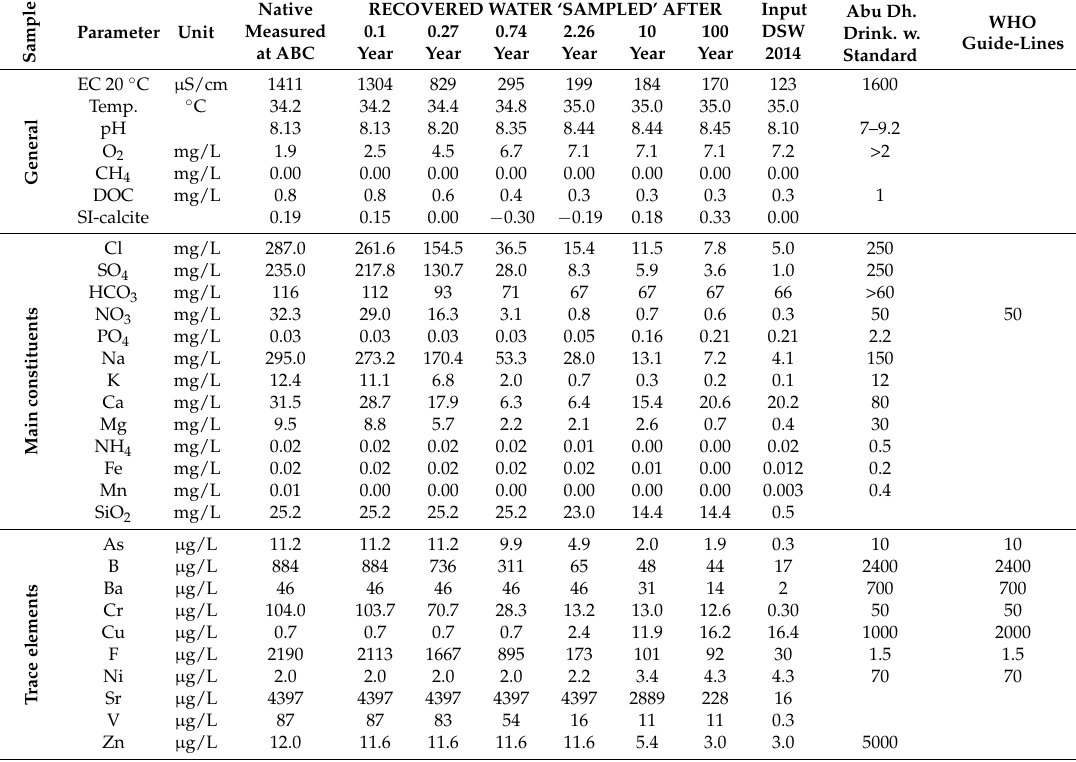
Table 5. Overview of water quality in the SWSR ASR scheme, showing input DSW (Desalinated Seawater), mean native groundwater (when sampled by all wells) and groundwater as if it were periodically sampled after 0.1 to 100 years during nonstop DSW